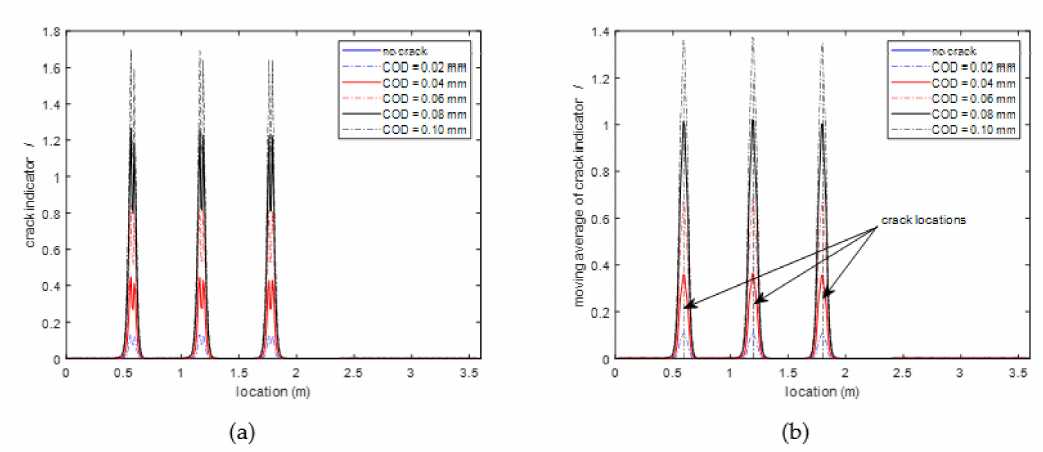
Figure 13. Crack indicator and moving averaged crack indicator along the fiber with di ff erent widths of structural cracks ( a ) crack indicator ( b ) moving average of crack indicator.